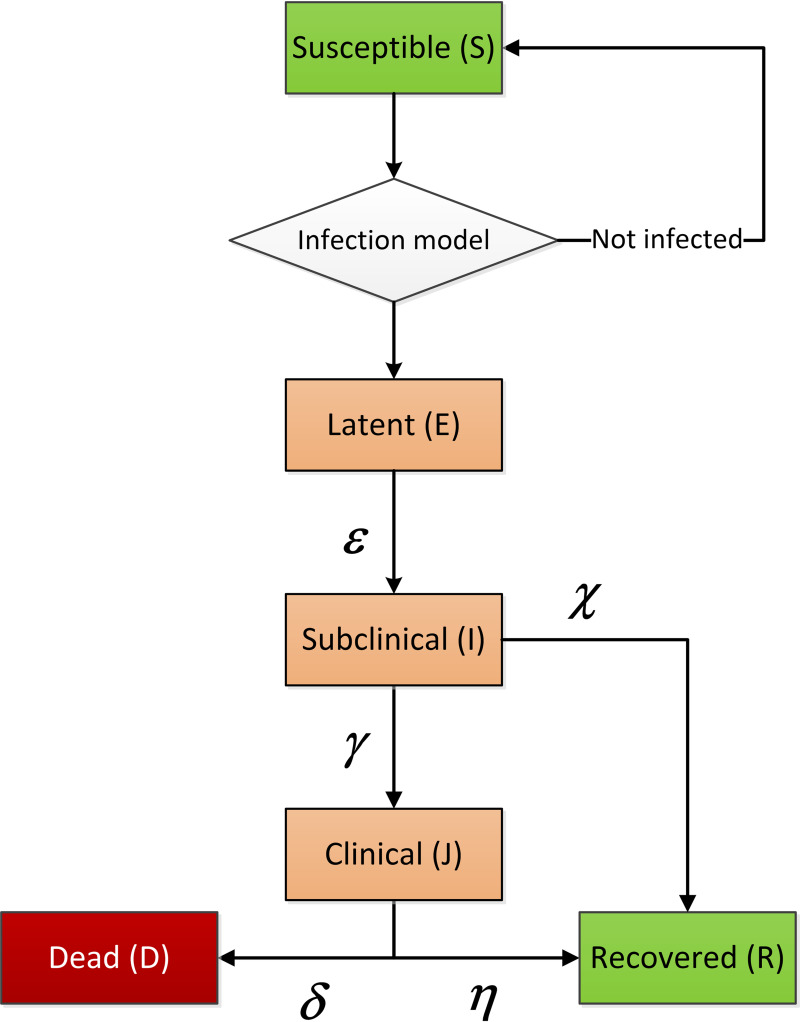
The disease model implemented for FMD.An animal that becomes exposed to FMD is located at the top in the susceptible state. The infection model determines if the animal becomes infected and thereby is moved to the latent state or if it remains in the susceptible state. The animal is thereafter transferred through the model at a stochastic pace and path with probabilities determined by the set of model parameters depicted in the figure.